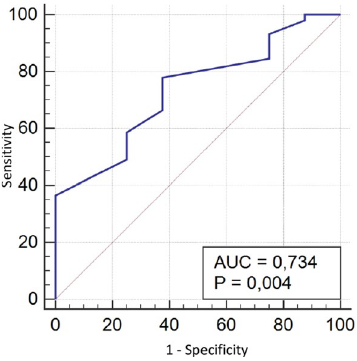
Fig. 1 Receiver operating characteristics (ROC) curve analysis the new early warning score (NEWS) in predicting ICU mortality P‑053 Which optimal dose of enoxaparine in burn patients Sarra Dhraief, Kawther Faleh, Meriem Oueslati, Hana Fredj, Amel